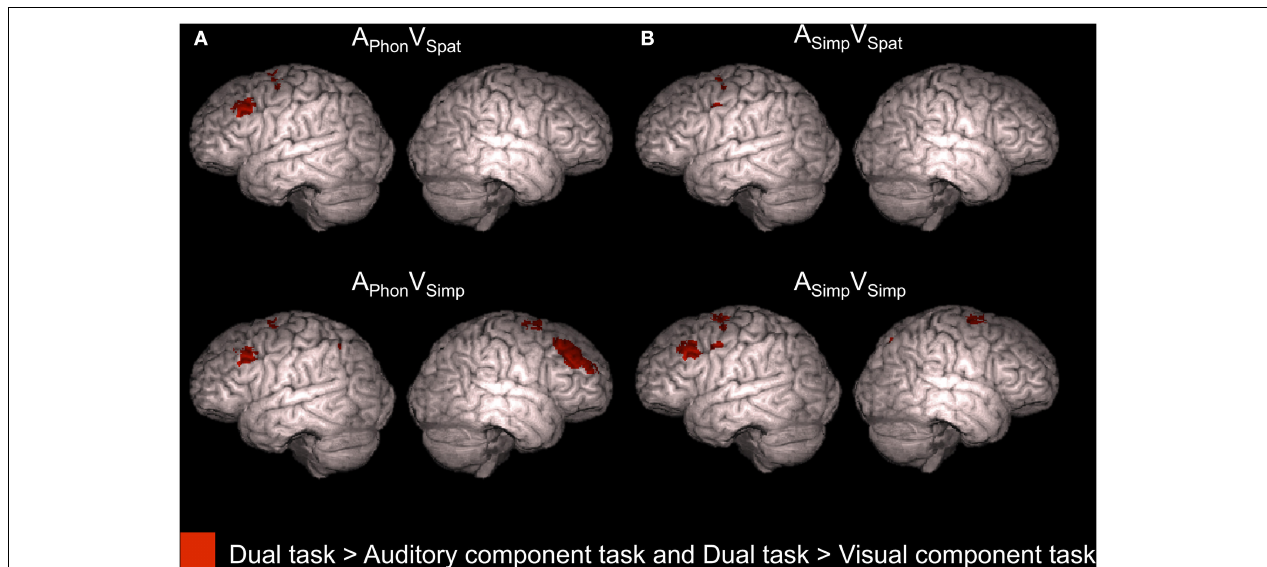
FIGURE 5 | Activity enhancements during dual tasks in relation to single tasks. According to conjunction analyses, the colored areas showed higher activity ( Z > 2 . 3, cluster corrected P < 0 . 05) for each of the four dual tasks of